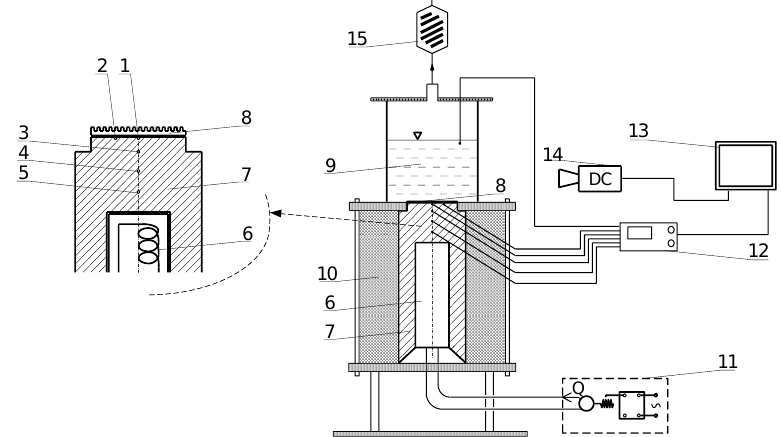
Figure 3. Boiling test set-up: 1 and 2, thermocouples below specimen; 3, 4, and 5, thermocouples in the copper block; 6, heater; 7, copper block; 8, specimen; 9, fluid; 10, thermal insulation; 11, power supply; 12, temperature recording unit, 13, computer; 14, digital camera; and 15, water-cooled coil (figure based on the authors' work [42]).